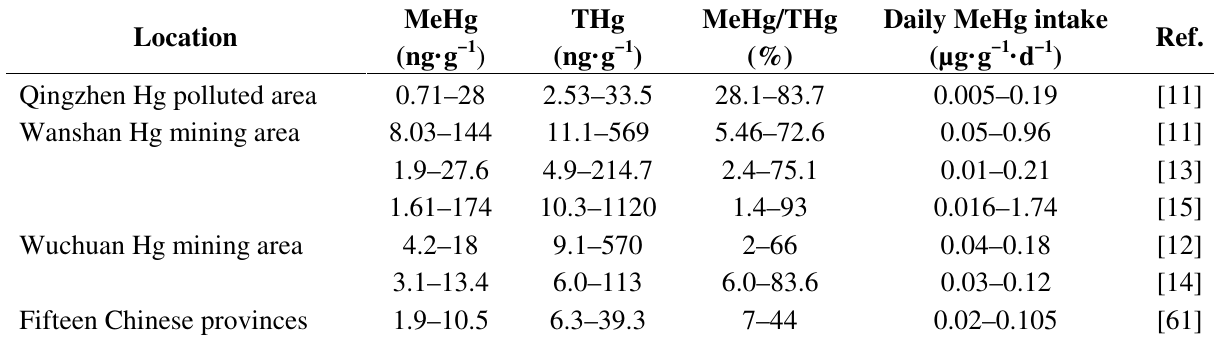
Table 1. Hg concentrations in the rice from Guizhou Province and other regions in China.